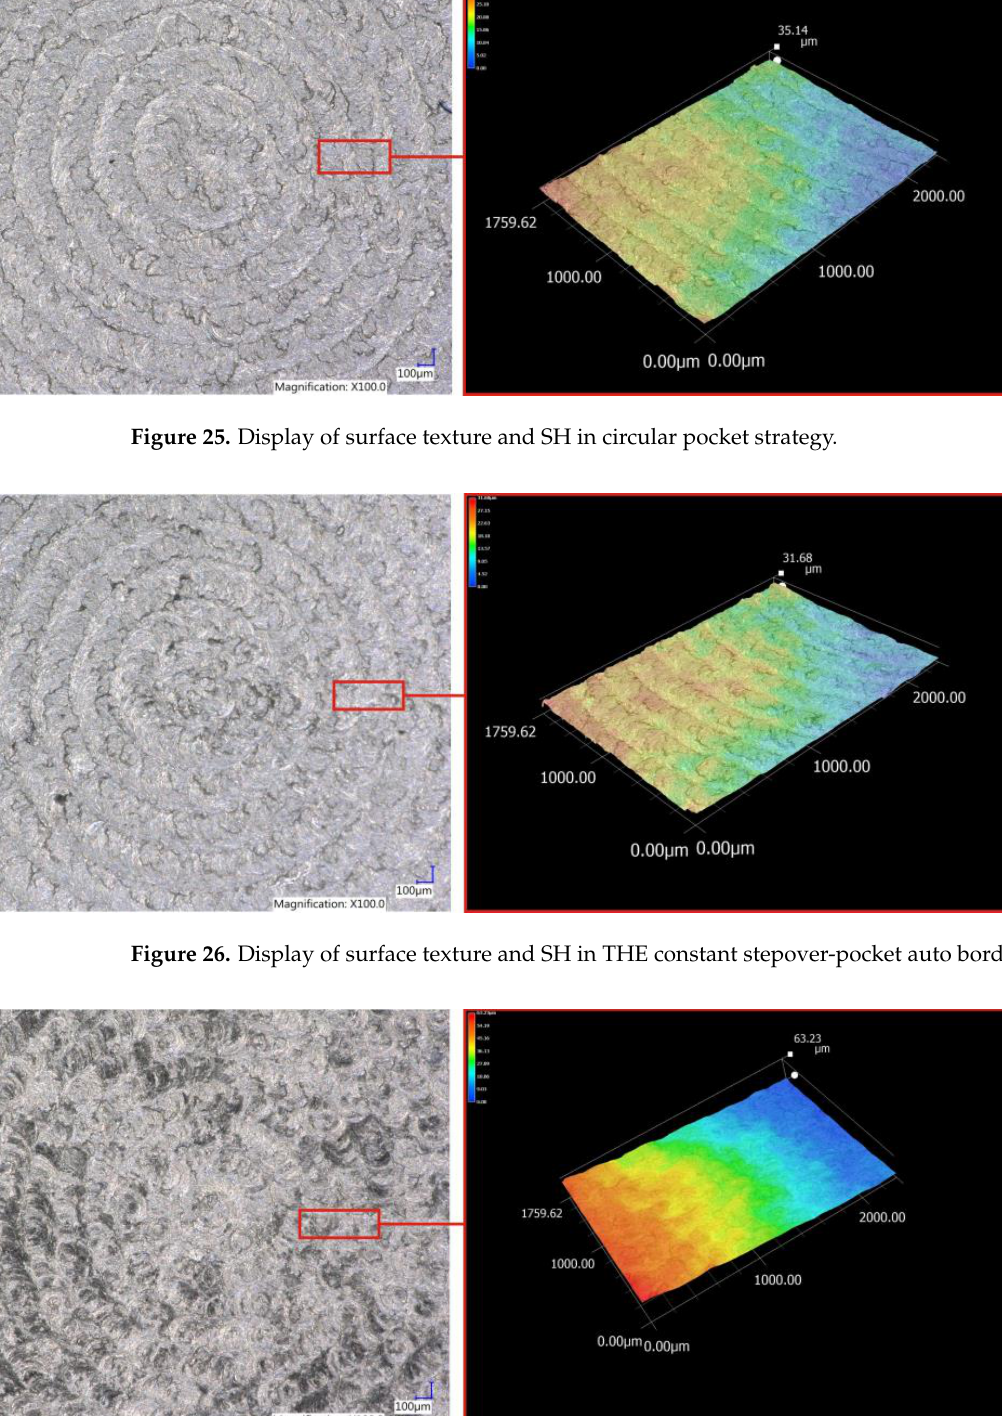
Figure 27. Display of surface texture and SH in THE spiral strategy. The obtained values of the residual scallop height after milling in particular positions in relation to Figure 6a are complemented by the graphical representation in Figure